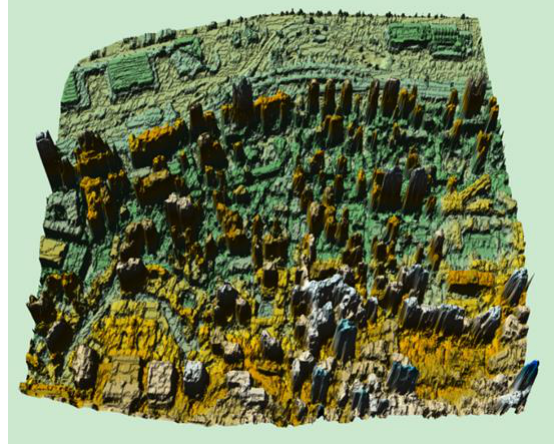
Fig.10 The DSM from the proposed method in Hong Kong